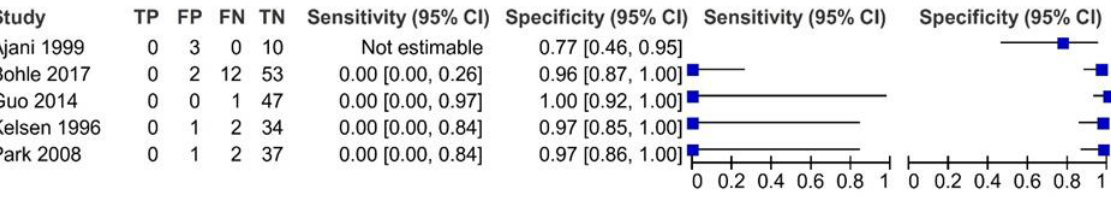
Figure 3. Forest plot for T1 restaging.